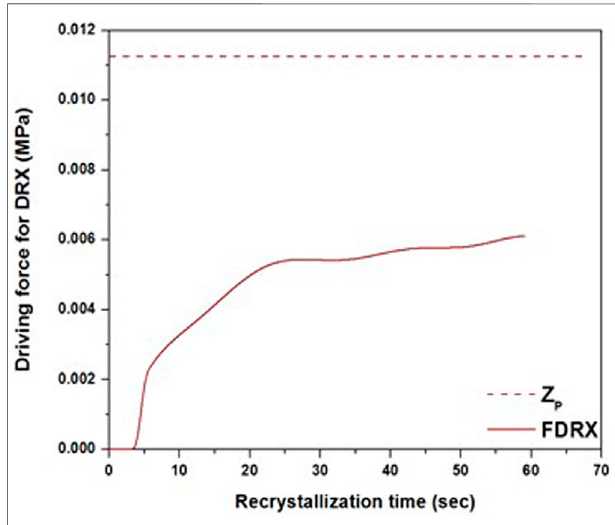
FIGURE 10 | Comparison between Zener force (Zp) and dynamic recrystallization (DRX) force (FDRX) for 950 ° C strain rate 0.01 s − 1 .